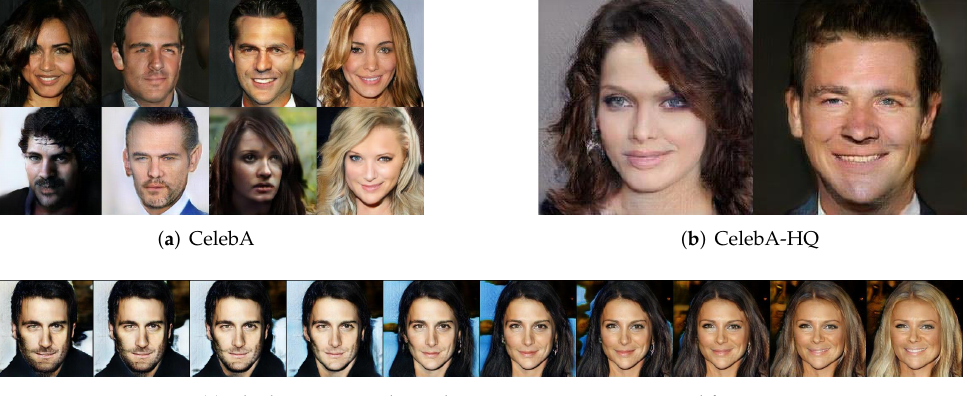
Figure 5. The generated results trained on the CelebA and the CelebA-HQ